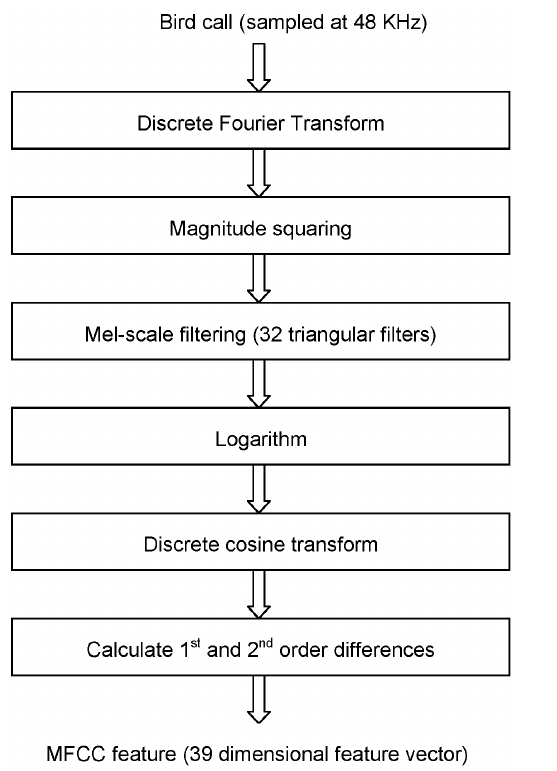
Figure 2. Flow chart showing the procedure for computation of mel-frequency cepstral coefficients.